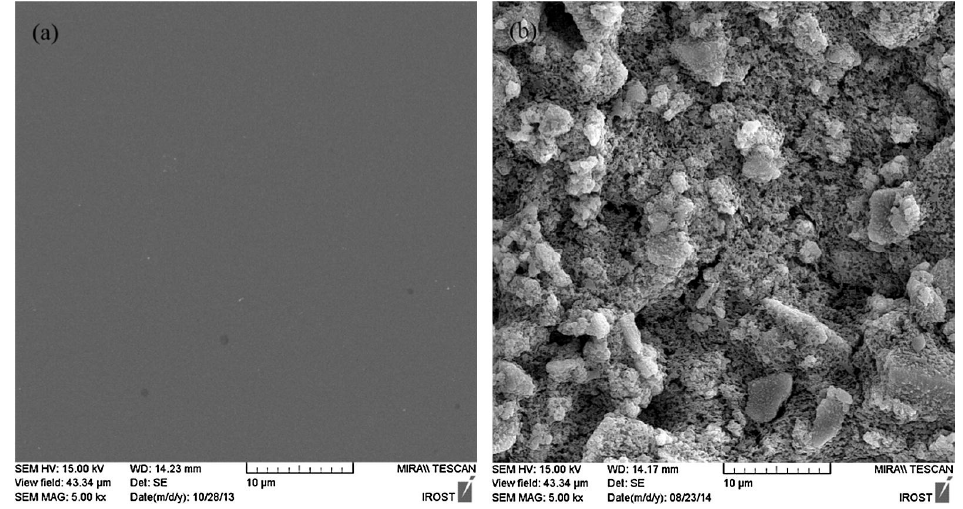
Figure 7. FE-SEM images of ( a ) TiO 2 films and ( b ) mesoporous TiO 2 films. Reprinted with permission from reference [38]. Copyright 2018, Elsevier.